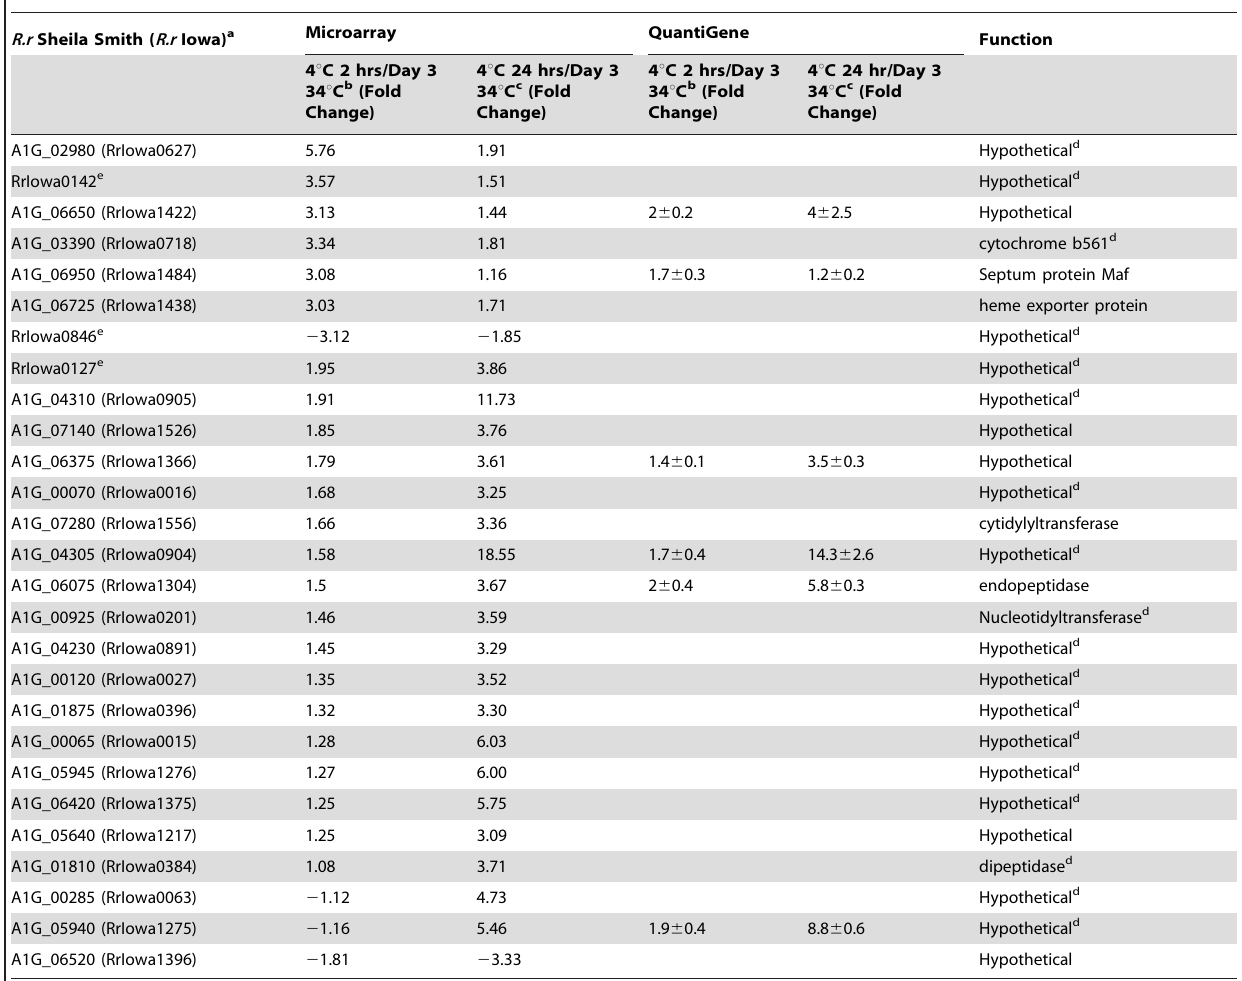
Table 4. Genes that differentially respond early or late after shift to 4 u